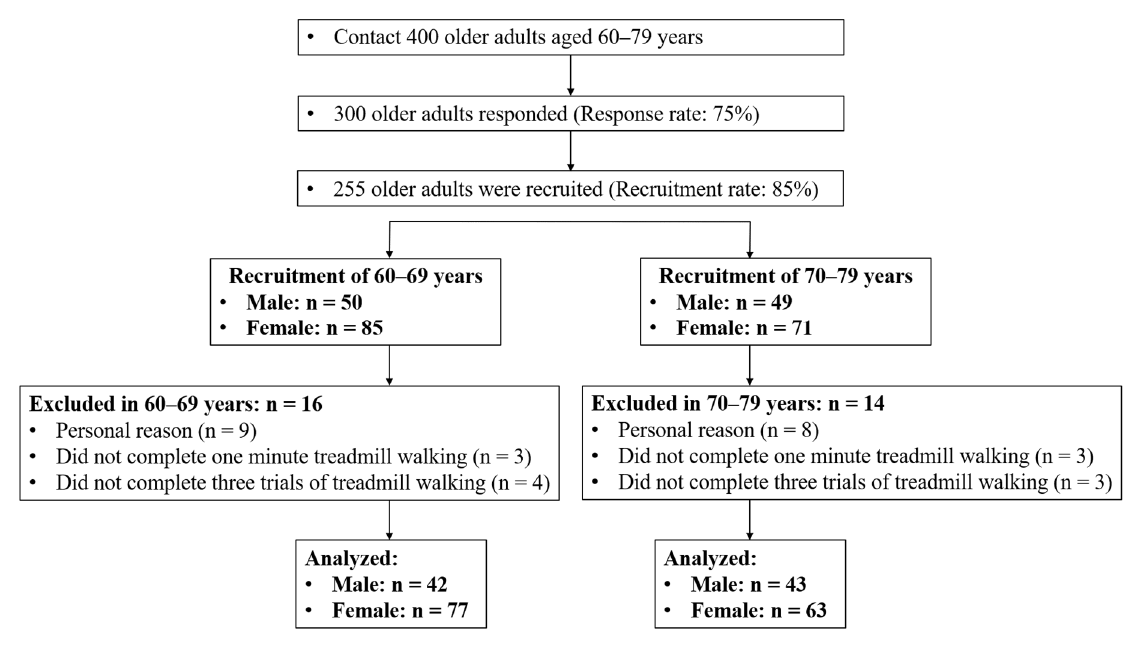
Figure 1. Flow diagram of participant recruitment process.